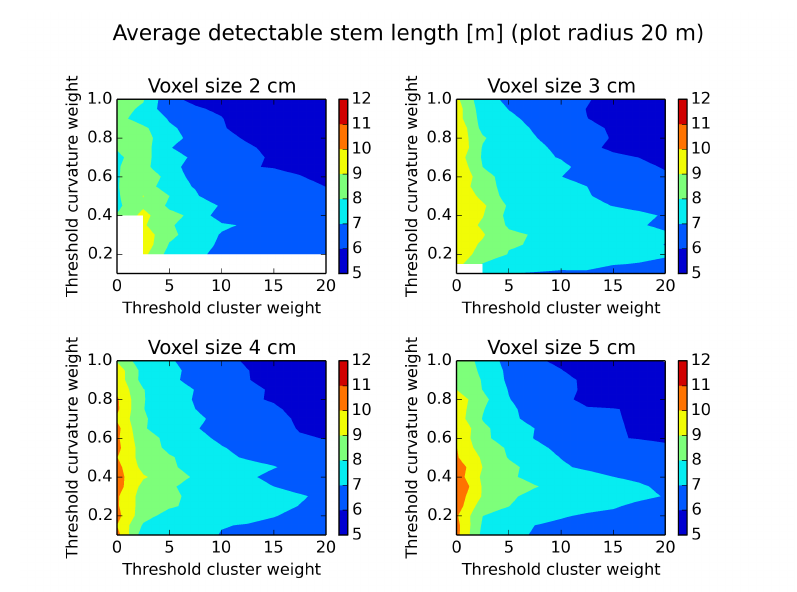
Figure 13. Average detectable stem length evaluated on a plot of a radius of 20 m and different parameter settings. White areas indicate missing data. Low threshold parameter values give many estimated stem diameters along the